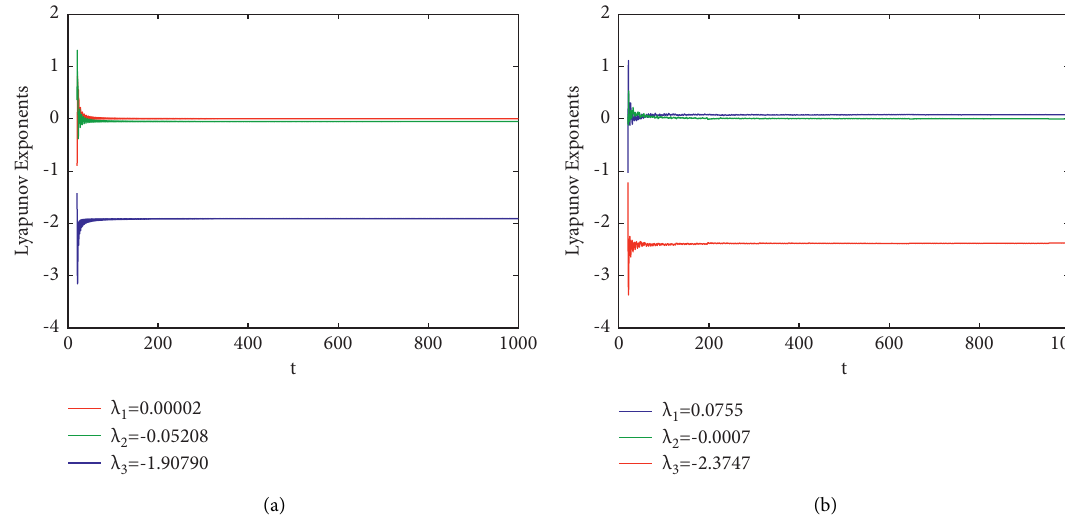
Figure 10: Lyapunov exponents spectrum of the Rucklidge system. (a) ( a, b ) � ( 0 . 96 , 6 . 7 ) and (b) ( a,b ) � ( 1 . 3 , 6 . 7 ) .